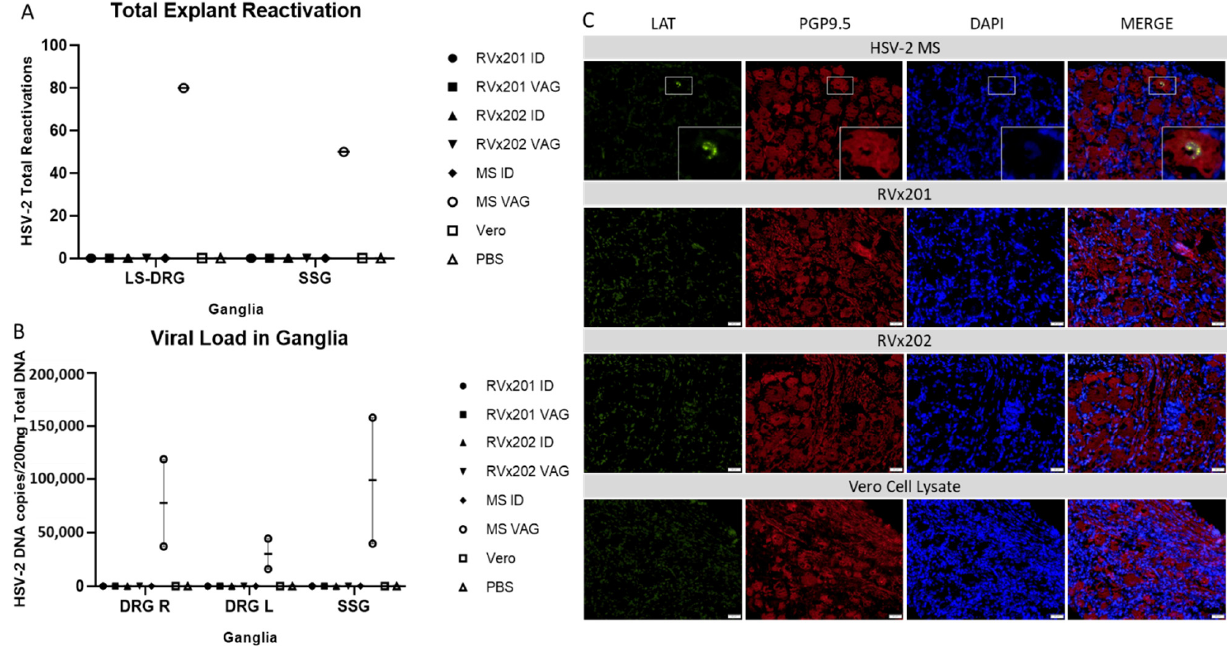
Figure 4. Establishment of latency in lumbosacral dorsal root ganglia (DRG) and sacral sympathetic ganglia (SSG). Following euthanasia, sensory and autonomic ganglia including LS-DRG, SSG, TG, SCG, and brain were assessed for HSV latency (TG, SCG, brain not shown, all negative). ( A ) Tissues were maintained in culture for 7 days and assessed daily for infectious virus released into media by plaque assay. Only guinea pigs inoculated VAG with MS reactivated. ( B ) DNA was extracted and HSV-2 quantified via qPCR targeting HSV-2 thymidine kinase (LOD: 10 2 copies) in right DRG (R-DRG, p = 0.0071 vs. PBS), left DRG (DRG-L, p = 0.0030 vs. PBS), and SSG ( p = 0.0174 vs. PBS). ( C ) Fluorescent in situ hybridization (FISH) for latency associated transcript (LAT) in LS-DRG. Cryosections of LS-DRGs were stained for LAT using FISH (green) and for sensory neuronal marker PGP9.5 using immunofluorescence (red), and counterstained using DAPI (blue). The individual color channels were then merged (far right). LAT was detected by FISH only in LS-DRG of guinea pigs infected with WT HSV2 MS, not in those infected with RVx201, RVx202, or mock-infected with Vero cell lysate or PBS. Data are presented as mean ± SEM. P values were determined by ANOVA and post hoc Tukey’s test.